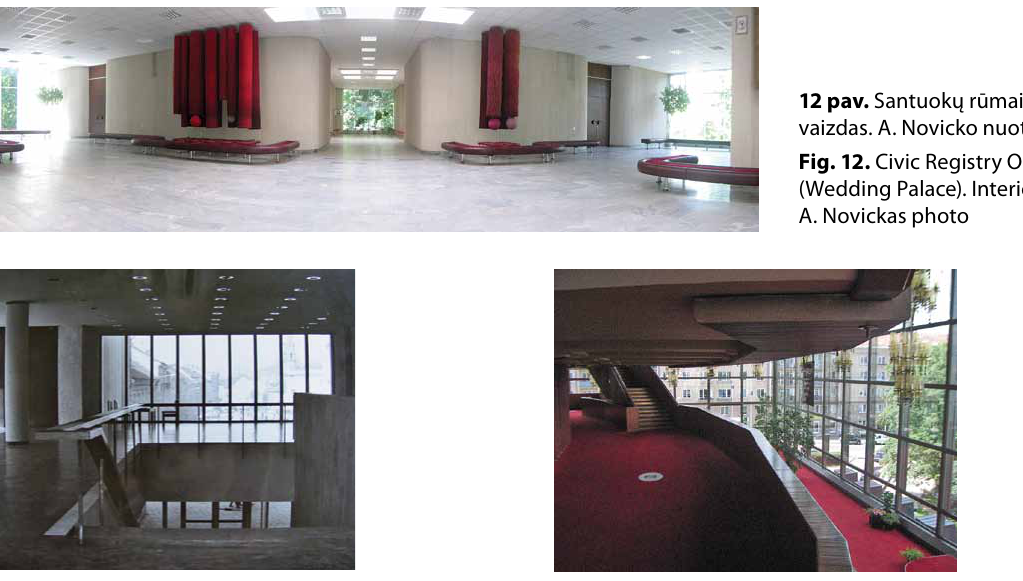
Fig. 13. View of the second floor hall of the Palace of art Exhibitions. Photo from the V. Čekanauskas family archive